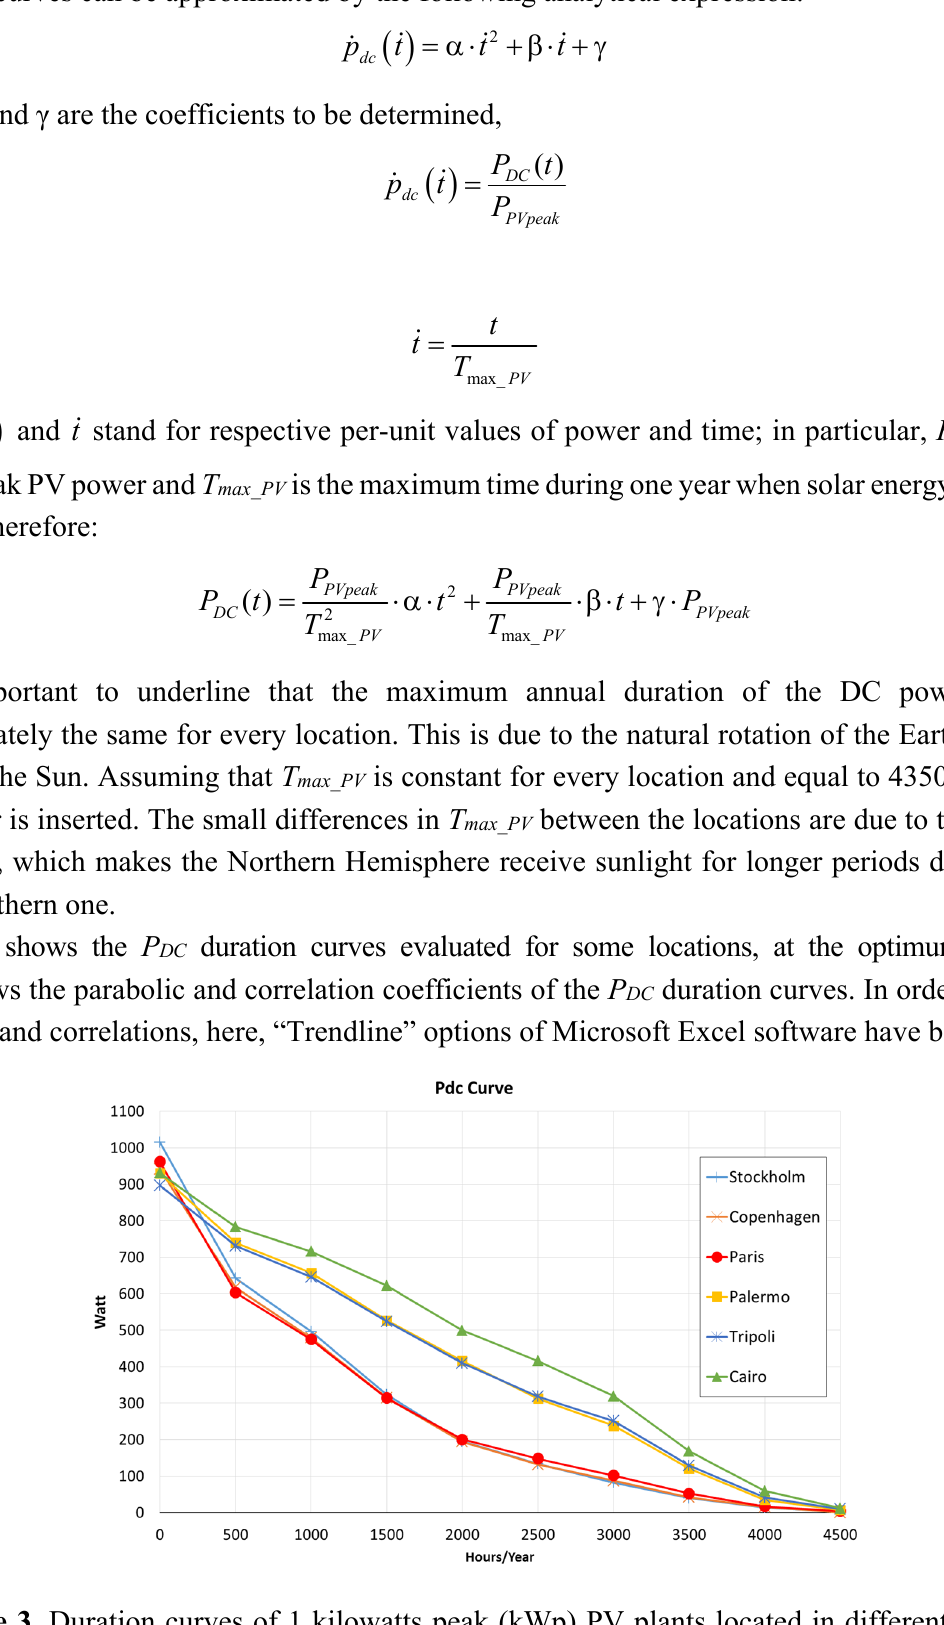
Figure 3. Duration curves of 1 kilowatts peak (kWp) PV plants located in different cities with their optimal modules’